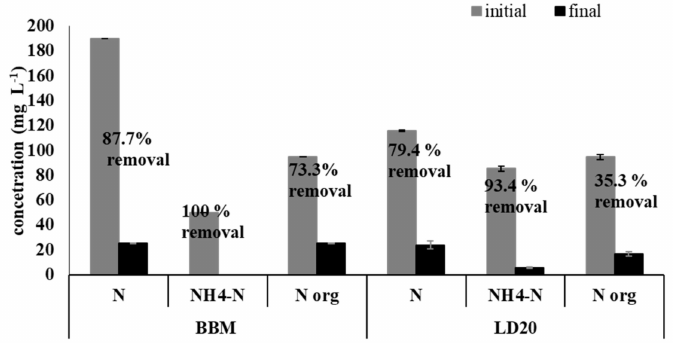
Figure 2. The initial and final concentration as well as the rate of removal of total nitrogen N, ammonia nitrogen NH 4 -N, and organic nitrogen Norg by A . protothecoides from BBM medium and liquid digestate (LD 20).